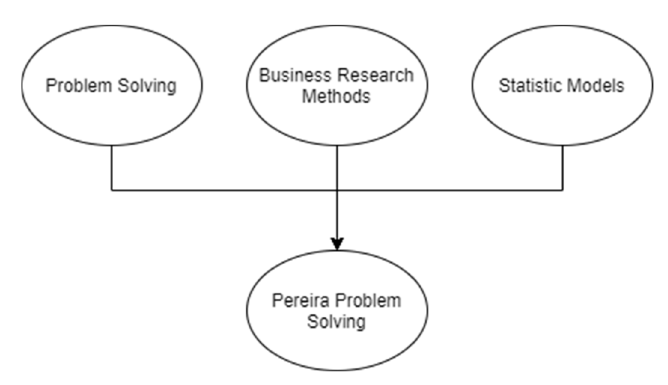
Figure 1. Methodology scheme